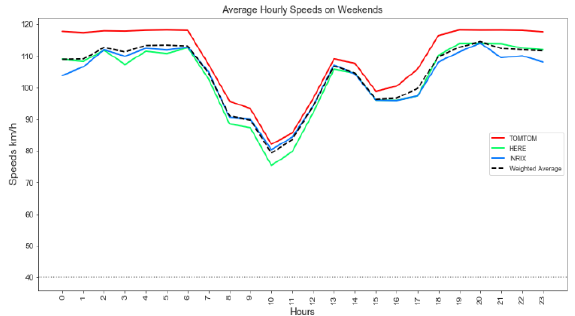
Figure 11: Time-of-day average speeds on weekends for the entire road section